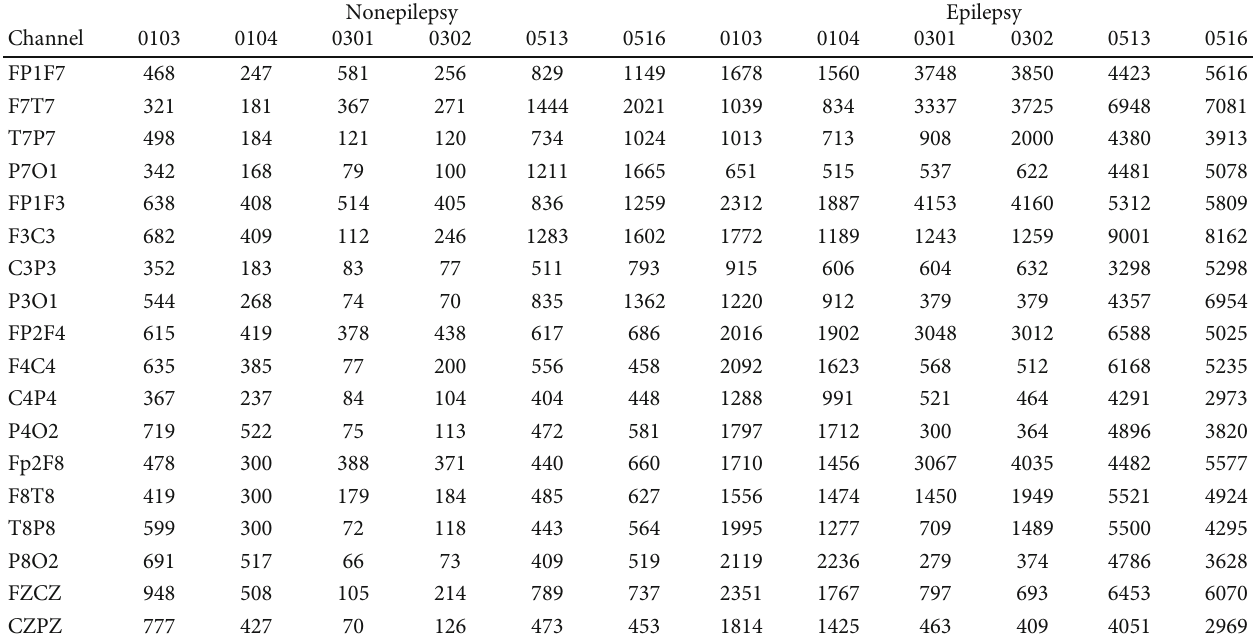
Table 2: PSD of 18 channels of